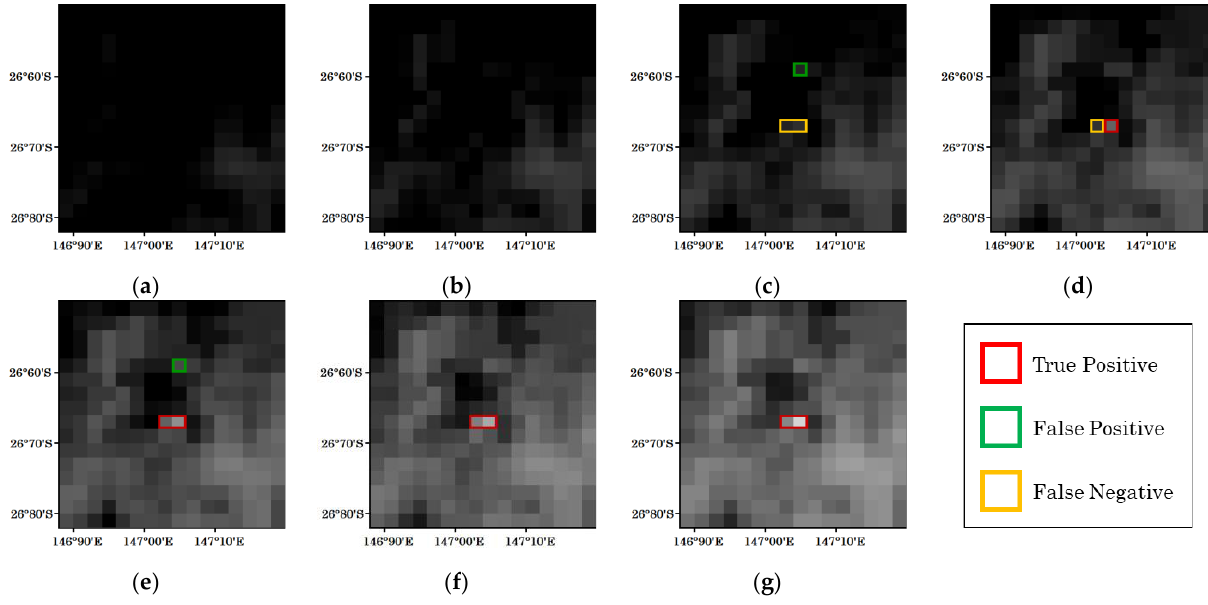
Figure 5. Example of detection results for a forest fire that occurred at 0:10 UTC on 27 May 2021. The observation times for each figure are ( a ) 23:50 (previous day), ( b ) 00:00, ( c ) 00:10, ( d ) 00:20, ( e ) 00:30, ( f ) 00:40, and ( g ) 00:50.